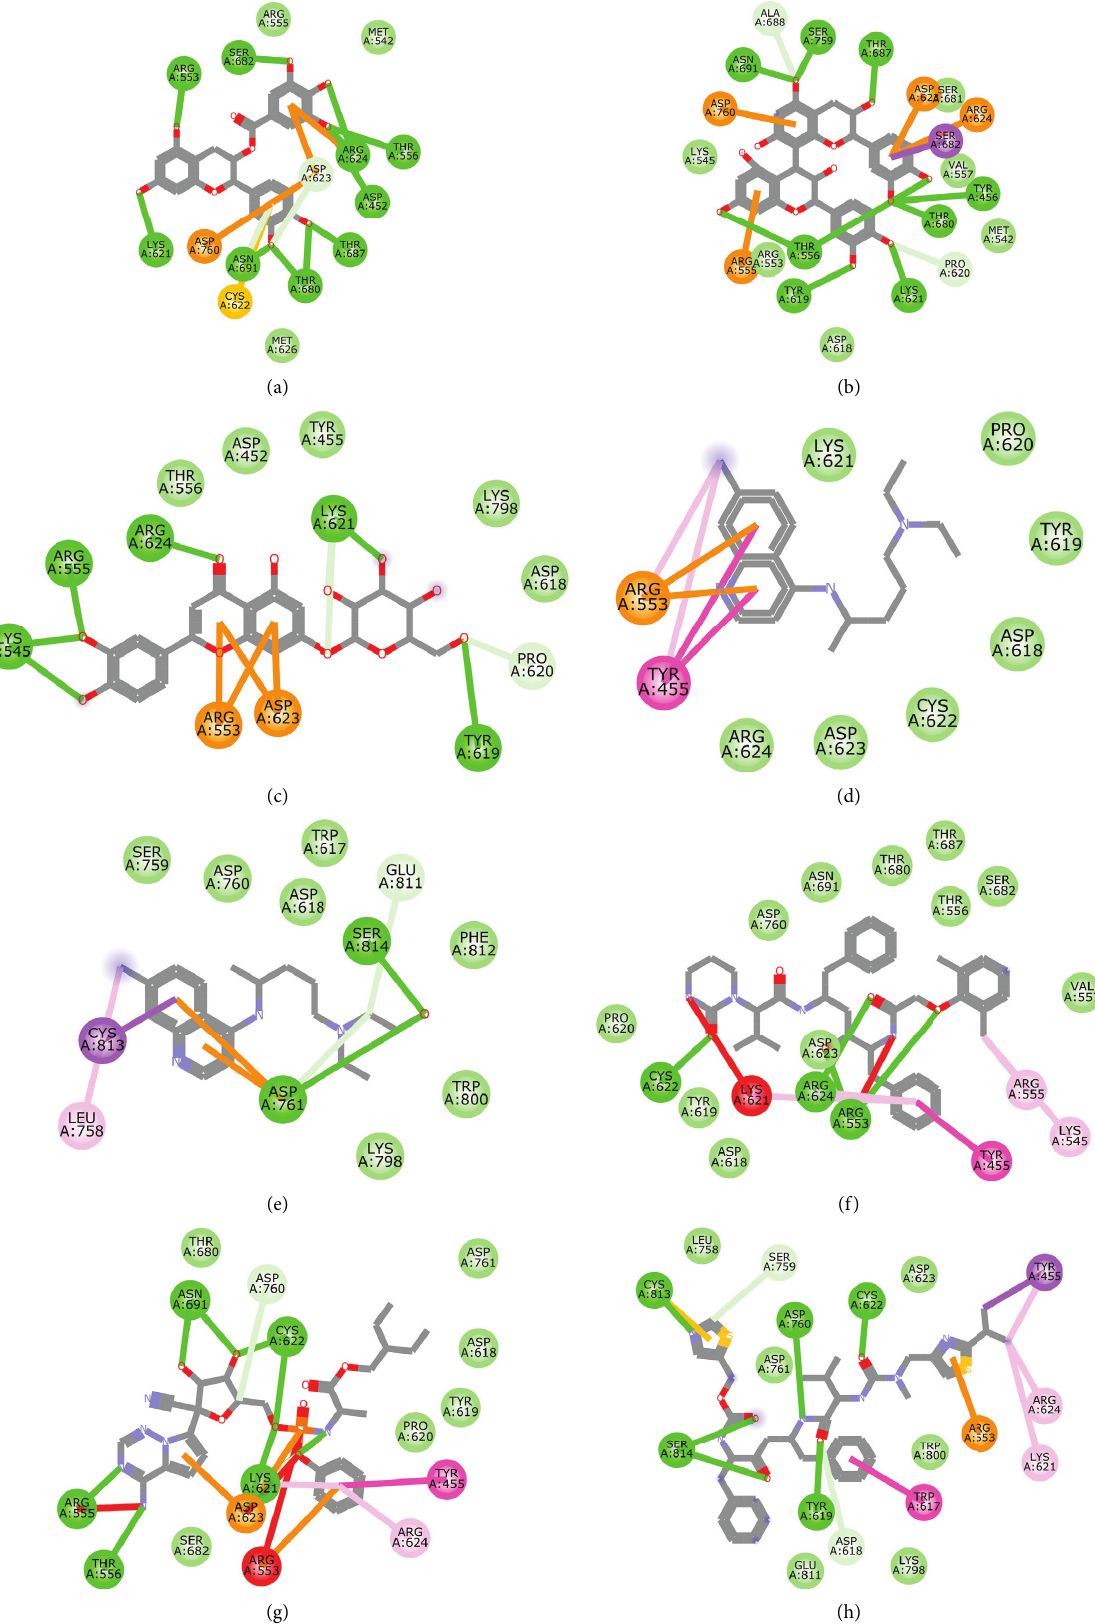
Figure 7: 2D representation of (a) 3-galloylcatechin, (b) proanthocyanidin B1, (c) luteolin 7-galactoside, (d) chloroquine, (e) hydrox- ychloroquine, (f) lopinavir, (g) remdesivir, and (h) ritonavir in the binding pocket of RdRp. Hydrogen, carbon-hydrogen, unfavourable, and π bonds are depicted as green, light blue, red, and any other coloured (purple, magenta, orange, turquoise blue, pink, and yellow) lines, while Van der Waal interactions appear as light green